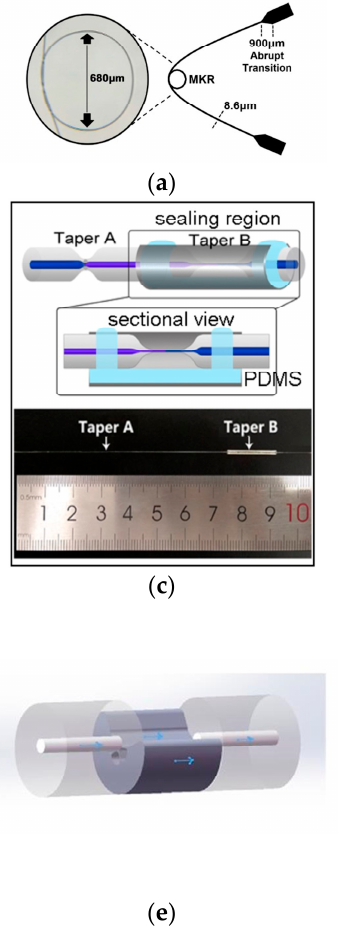
Figure 8. ( a ) Schematic of the proposed sensor and picture of the microfiber knot resonator [72]. ( b ) Microscopic image of the fabricated MAMZI [73]. ( c ) Schematic of the capsulation method and a photo of the MZI after sealing. Transmission spectra of MZI [74]. ( d ) Cross-section view of the ECF [76]. ( e ) Schematic of the sensor based on the SMF-ECF-SMF structure [77]. ( f ) Configuration of the SMDMS sensing structure [80]. Reprinted with permission from Ref. [77] © The Optical Society. Table 5. Summary of MZIs.